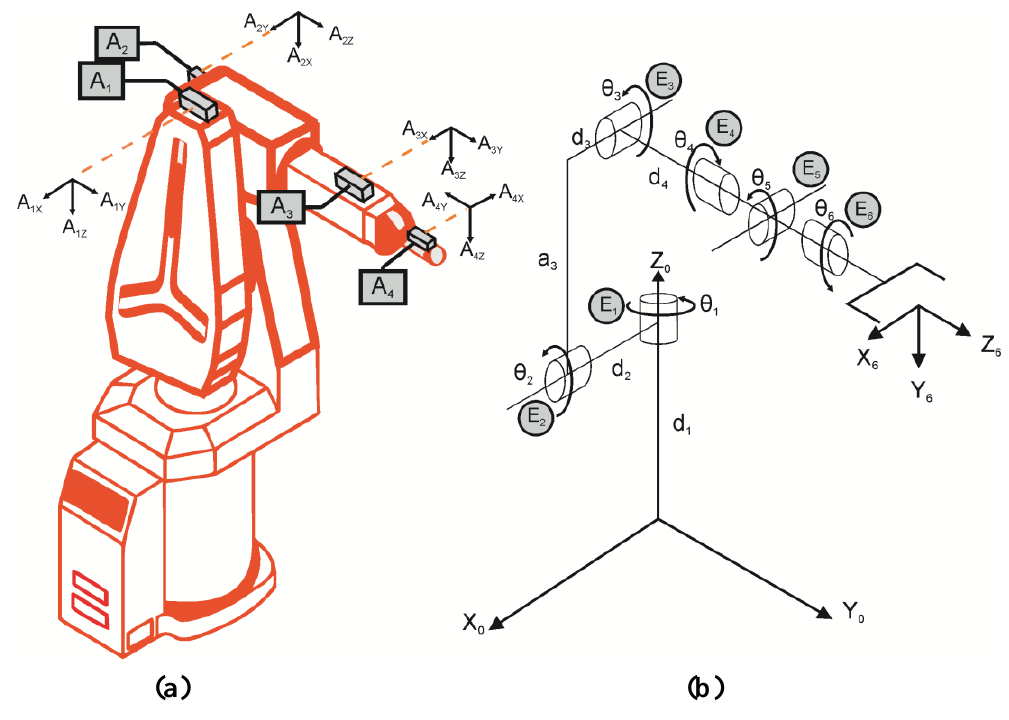
Figure 1. Sensor network location on the robot. (a) Accelerometer placement. (b) Schematic showing the parameters that describe the